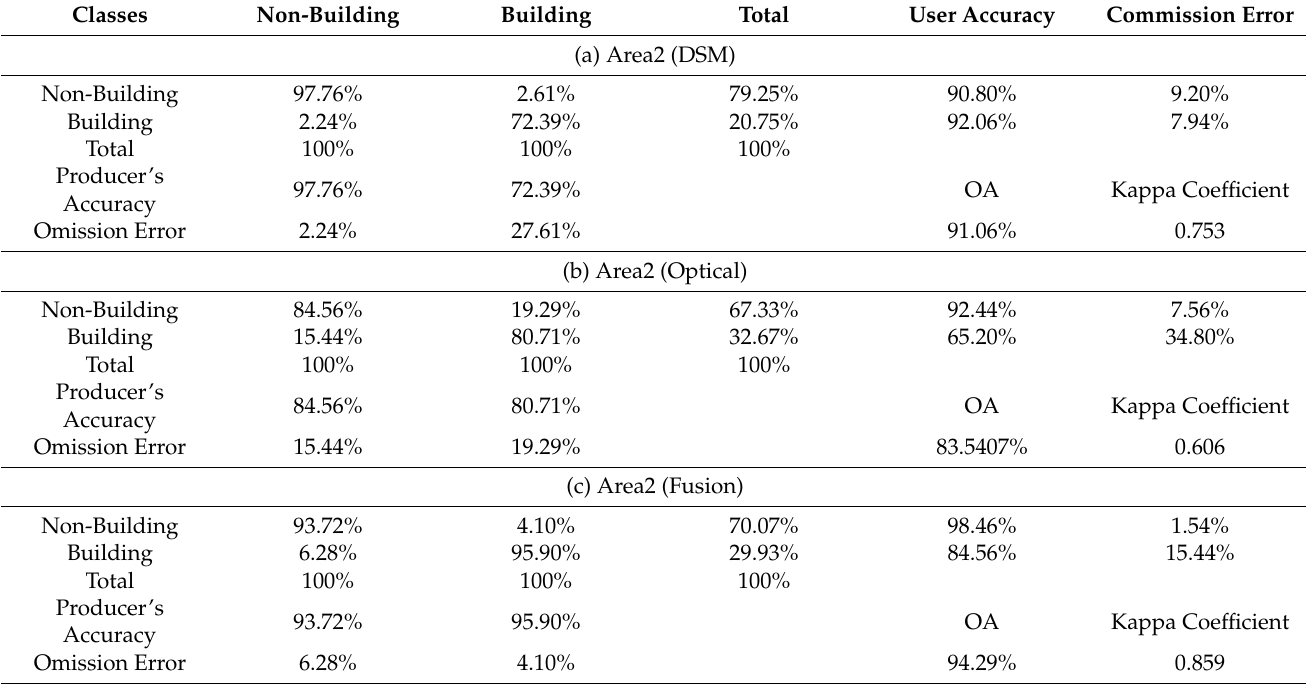
Table 2. The confusion matrix using the proposed method for Area2.